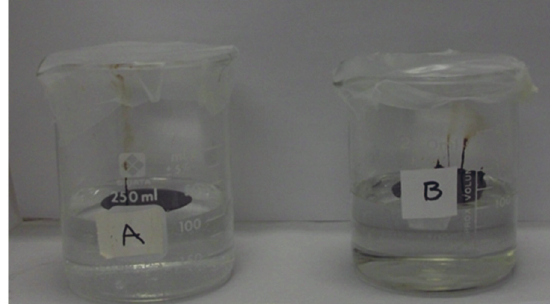
Figure 4. Bitumen samples in deionized water ( A ) and Instant Ocean solution ( B ) at room temperature (23 °C) and time = 0 h.